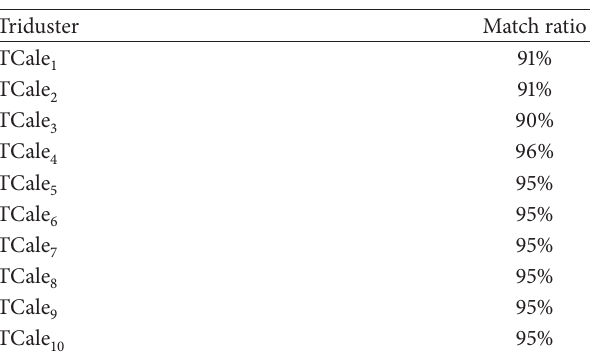
Table 2: TriGen algorithm synthetic match